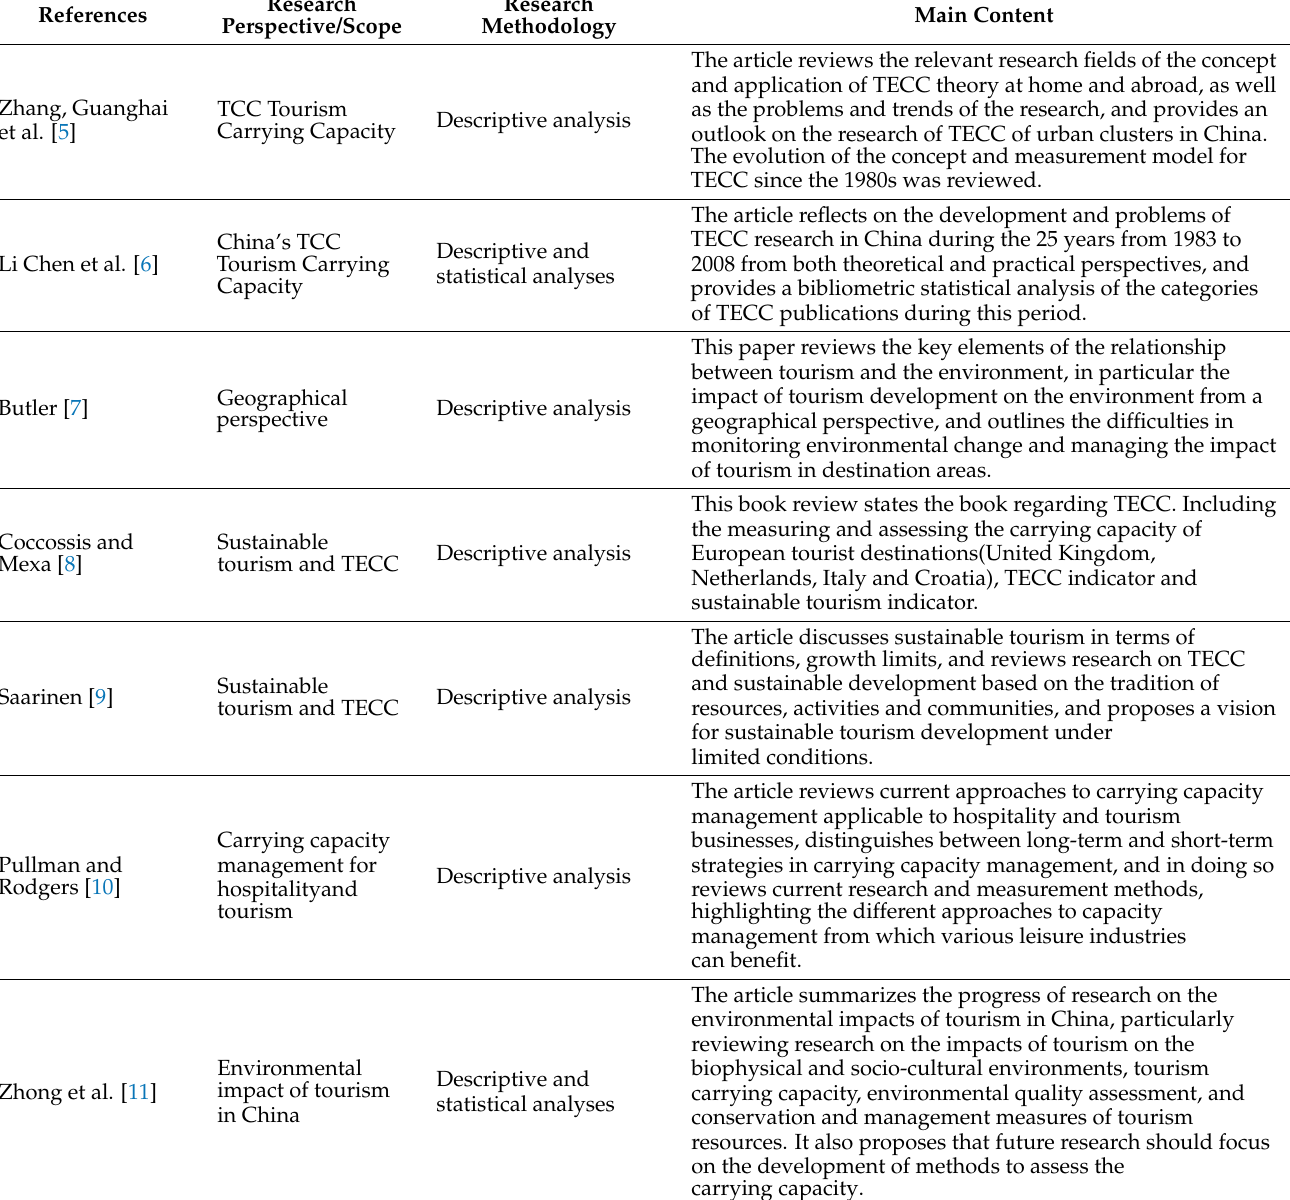
Table 1. Summary of 11 reviews on tourism carrying